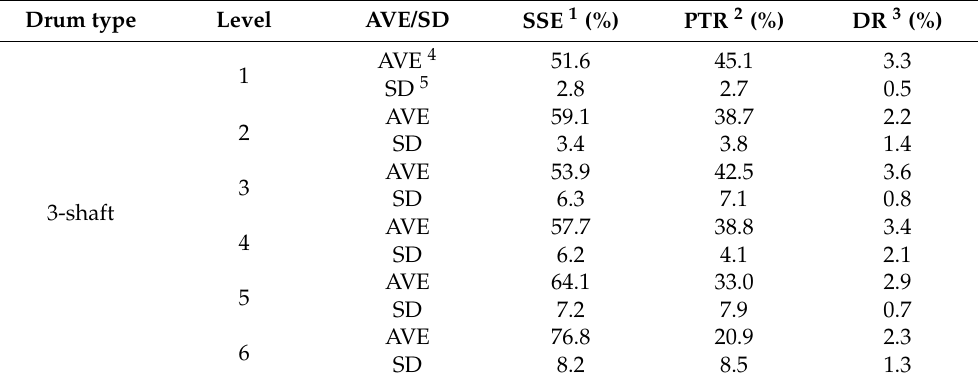
Table 4. Experiment results of field test based on drum type and rotational speed level.